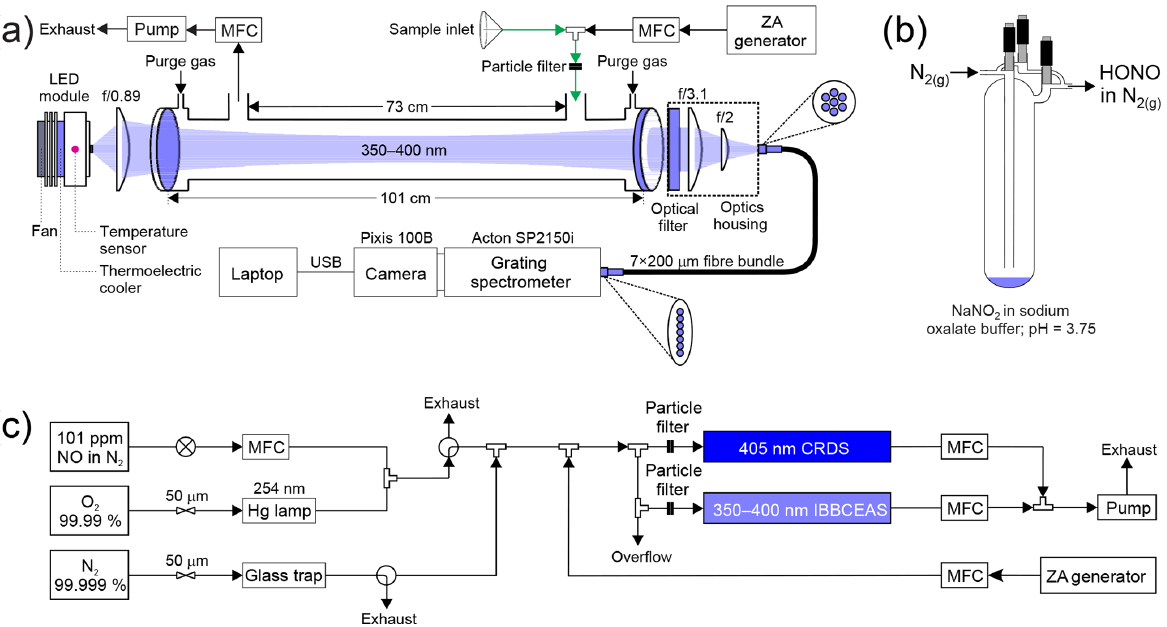
Figure 1. Schematics of (a) HODOR optical setup and ambient air sampling system. The optical portion of the instrument consists of temperature-stabilized LED module, collimating and focusing optics, band-pass filter, specialized fibre bundle, grating spectrometer, and a charge-coupled device array detector. Sample ambient air is pulled through a 2–4m long sampling inlet using a diaphragm pump. Zero air (ZA) is occasionally switched on from a cylinder or produced by a zero air generator. (b) A glass trap containing dissolved NaNO 2 showing HONO production in the gas phase while sampling in active mode. (c) Laboratory air sampling system for delivery of NO 2 and HONO for quantification by IBBCEAS and CRDS in parallel. MFC = mass flow controller. USB = universal serial bus.